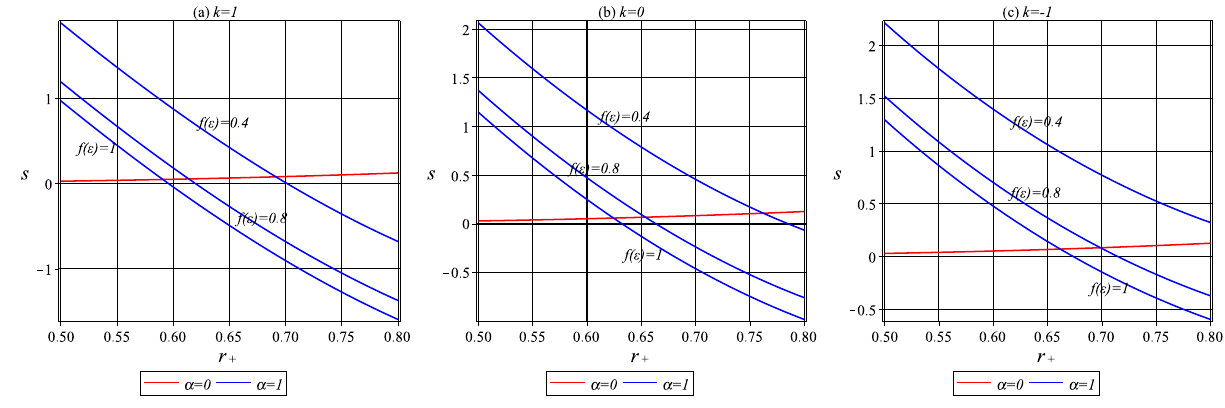
Fig. 12 Logarithmic corrected entropy in terms of r + for g (ε) ≈ 1, and unit value for other model parameters